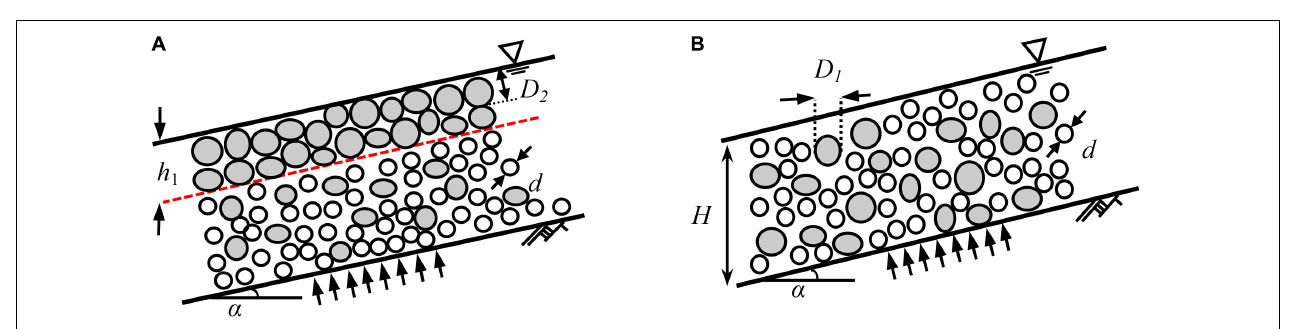
FIGURE 5 | Multiple surges of a debris flow event in JJG.